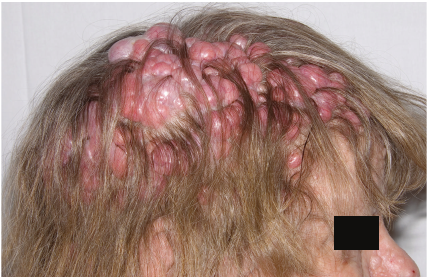
Figure 5: Clinical photographs of the multiple scalp lesions.